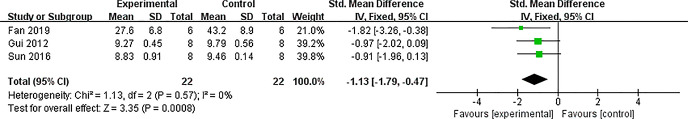
Effect of astragaloside IV on HbA1c vs control.